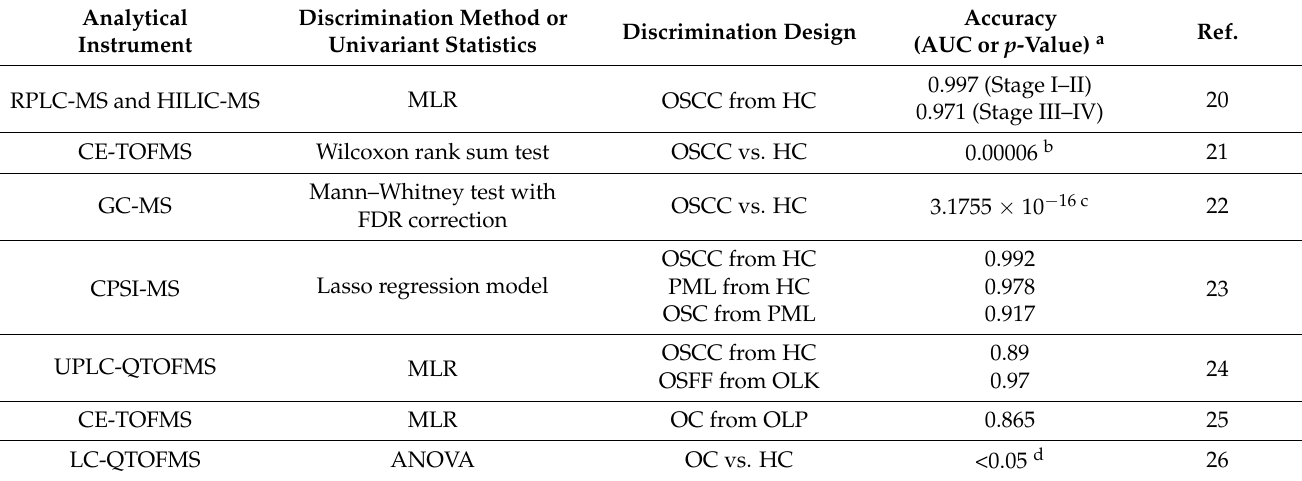
Table 1. Summary of salivary metabolomics for OC diagnosis